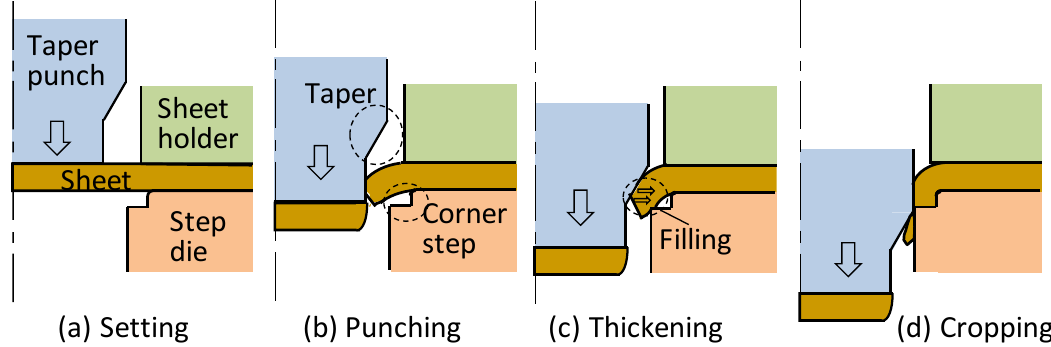
Figure 11. Punching process of thickened sheared edge for improving fatigue strength and the stiffness of punched ultra-high strength steel sheet; ( a ) setting, ( b ) punching, ( c ) thickening and ( d ) cropping [58].